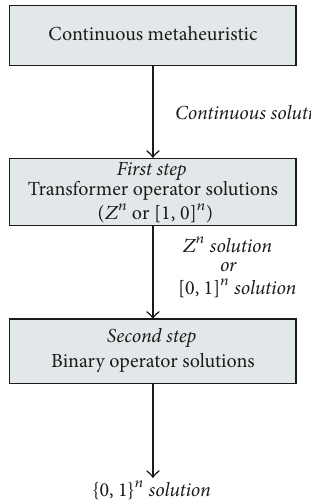
Figure 2: A general scheme for two-step binarization